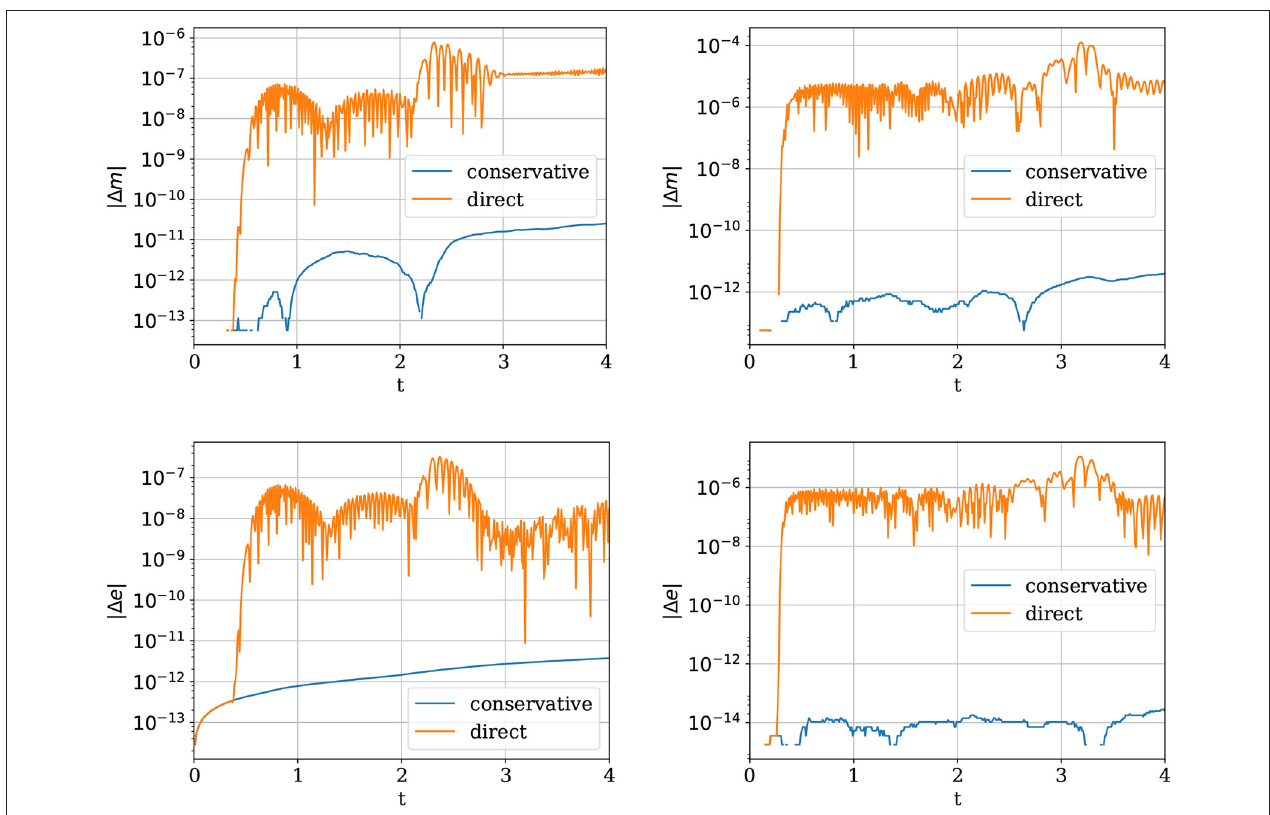
FIGURE 14 | Conservation of mass and energy testing. (Top Left) Mass conservation when MHD assumptions somewhat valid. (Top Right) Mass conservation when MHD assumptions invalid. (Bottom Left) Energy conservation when MHD assumptions somewhat valid. (Bottom Right) Energy conservation when MHD assumptions invalid. Validity of the MHD assumption produces an improvement in the conservation properties for direct variable translation.